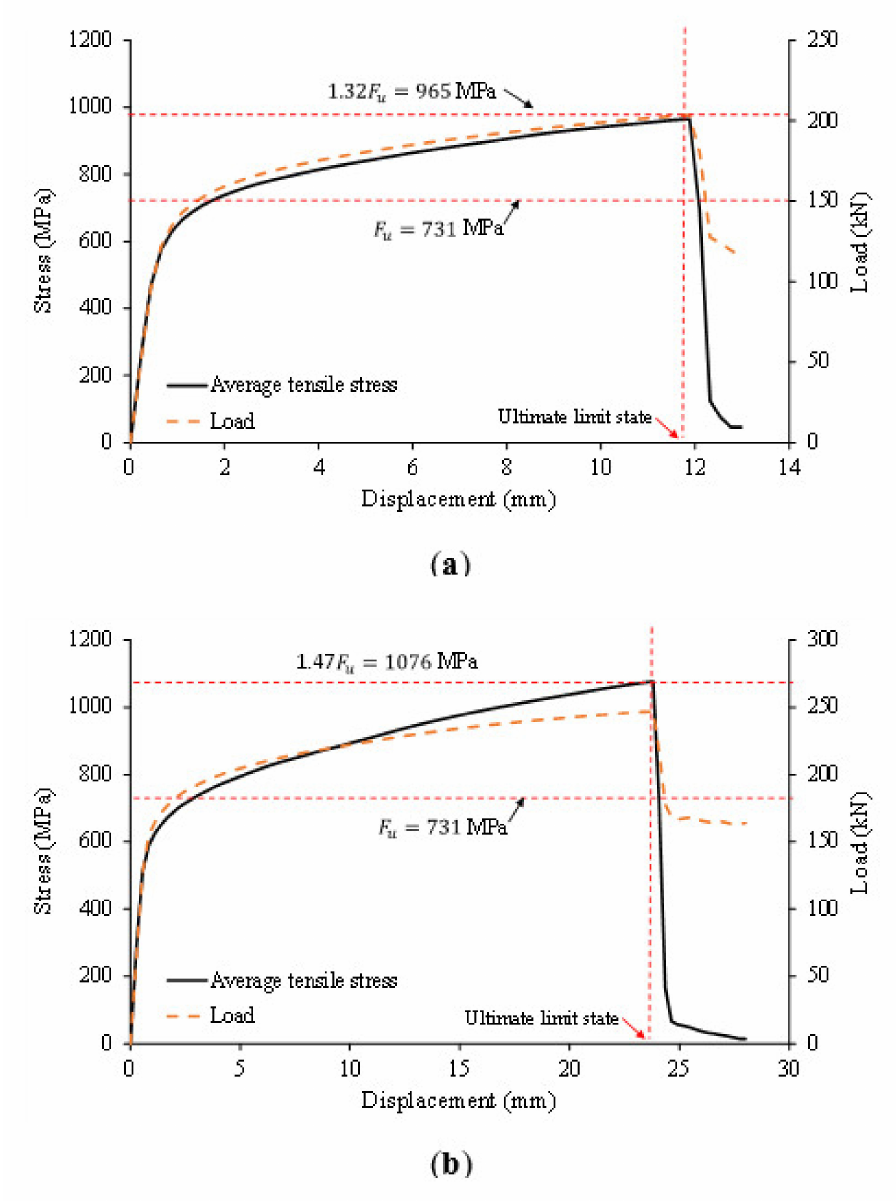
Figure 9. Average tensile stress: ( a ) Specimen L35W40; ( b ) Specimen